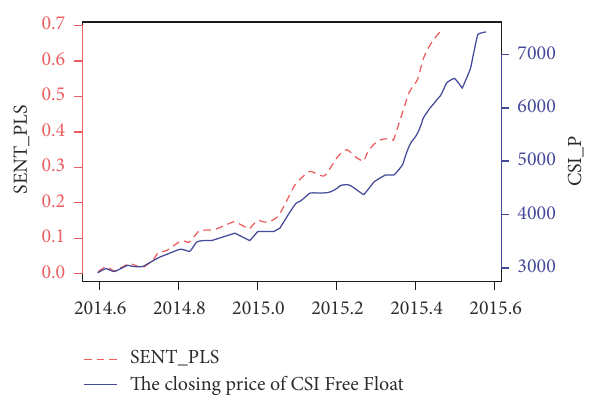
Figure 2: The comparison chart of the investor sentiment index and the closing price of CSI Free